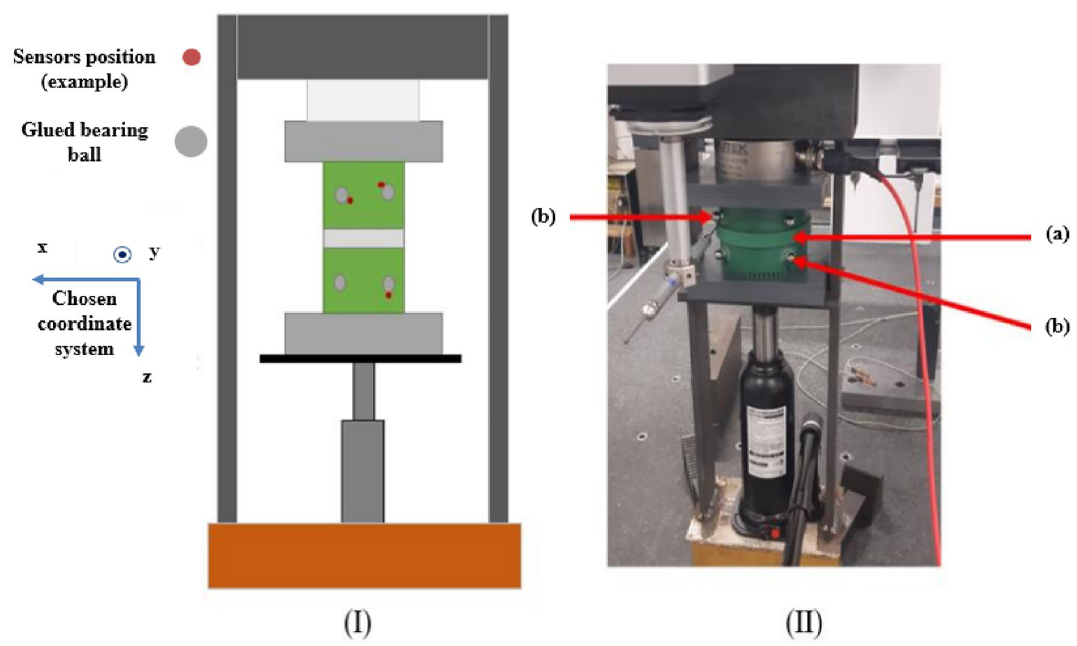
Figure 11. Principle of the metrology test; ( a ) centering ring; ( b ) bearing